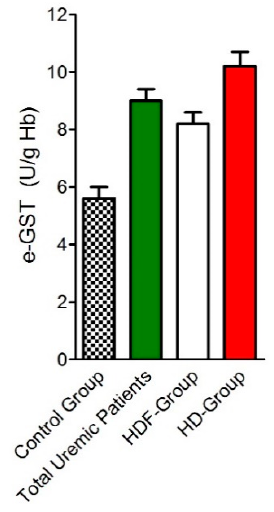
Figure 8. Erythrocyte glutathione transferase (e-GST) activity in uremic patients under two different dialysis techniques. e-GST activity in healthy subjects (control group), total uremic patients (green bar), patients in online hemodiafiltration (HDF-group) (white bar), and uremic patients in standard bicarbonate hemodialysis (HD-group) (red bar) (modified from Reference [41]). Single-pool Kt/V urea and total weekly Kt/V urea were higher in convective group with respects to diffusive group (1.5 ± 0.1 vs. 1.3 ± 0.1, and 4.6 ± 0.1 vs. 3.9 ± 0.2), but no significant correlation was